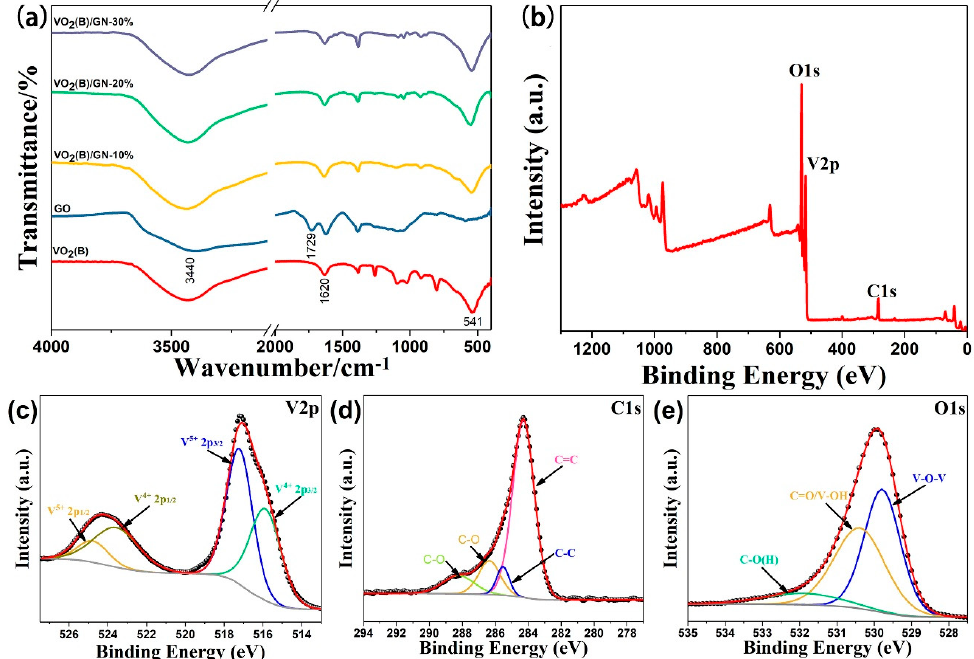
Figure 2. ( a ) FT-IR spectra of VO 2 (B), GO, and VO 2 (B)/GN composite, XPS spectra of VO 2 (B)/GN composite: ( b ) Survey peak; ( c ) typical V 2p; ( d ) typical C 1s and ( e ) typical O 1s. Table 1. XPS analysis of VO 2 (B)/GN.